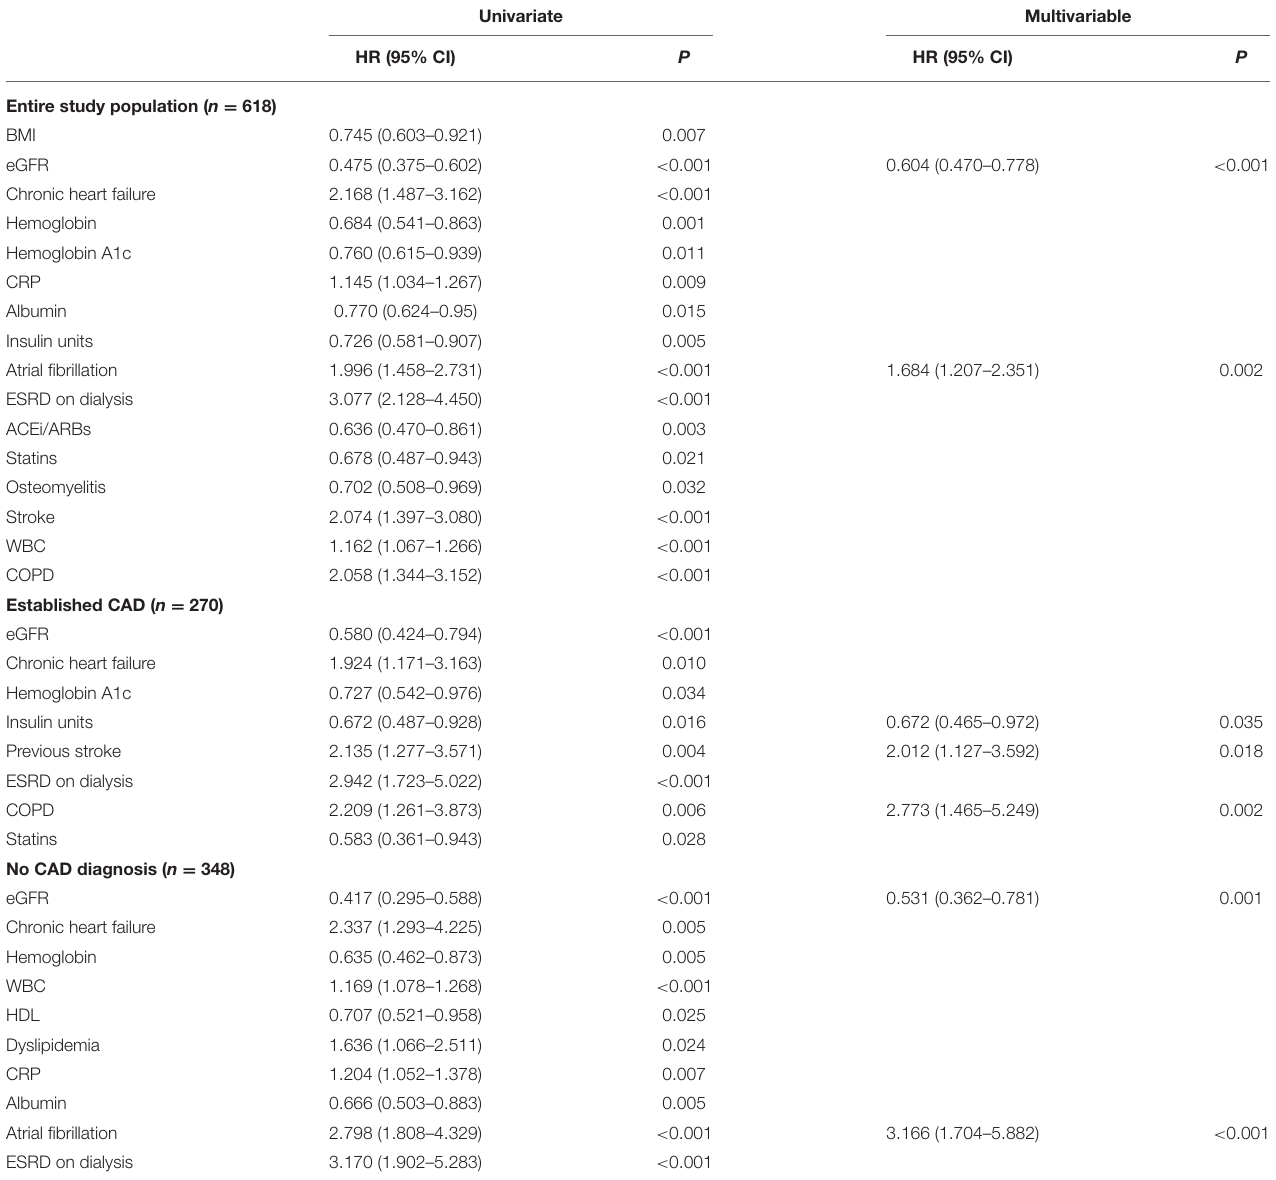
TABLE 2 | Univariate and multivariable Cox regression for the prediction of MACE. Univariate